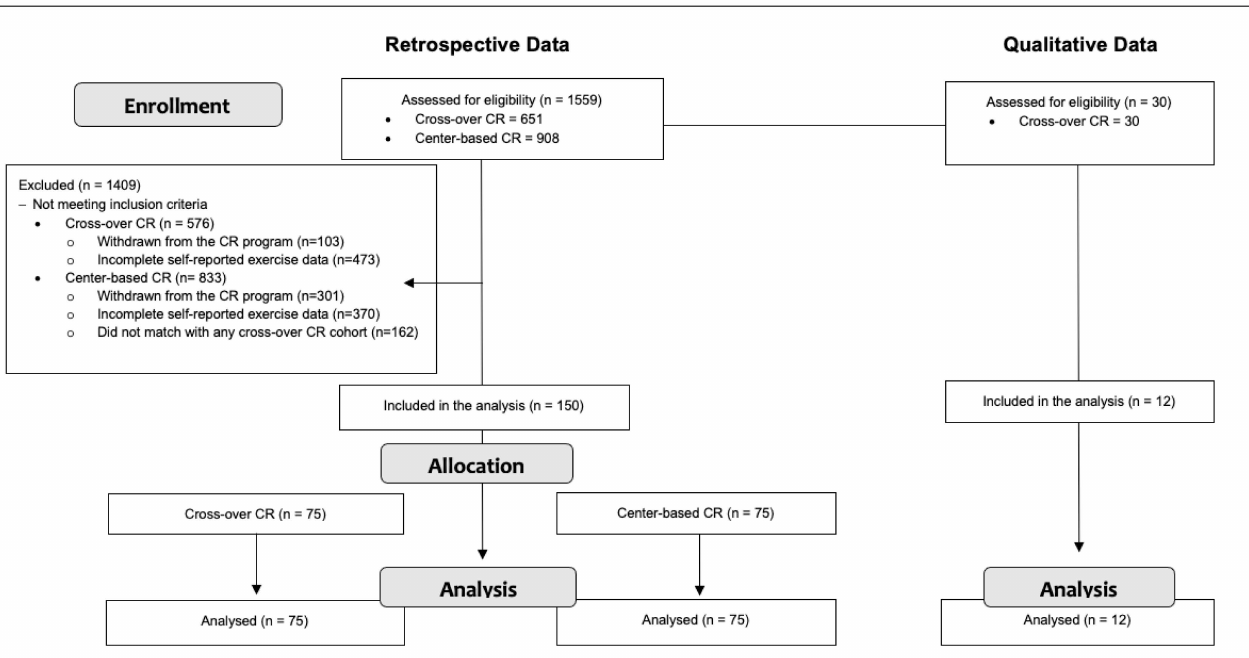
Figure 2. Study flow diagram. Abbreviation: CR = cardiac